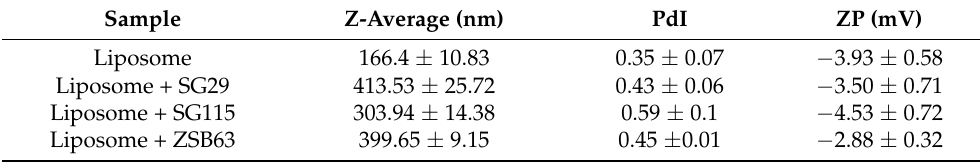
Table 2. Size, polydispersity index, and zeta potential of the examined liposomal